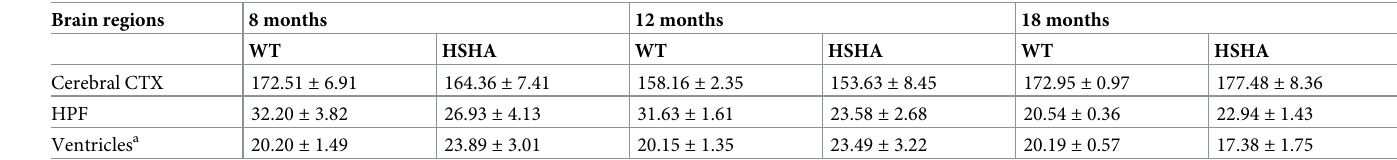
Table 2. Regional brain volume measurements (mm 3 ) and their variation with age in WT and HSHA mice at 8, 12, and 18 months. Brain